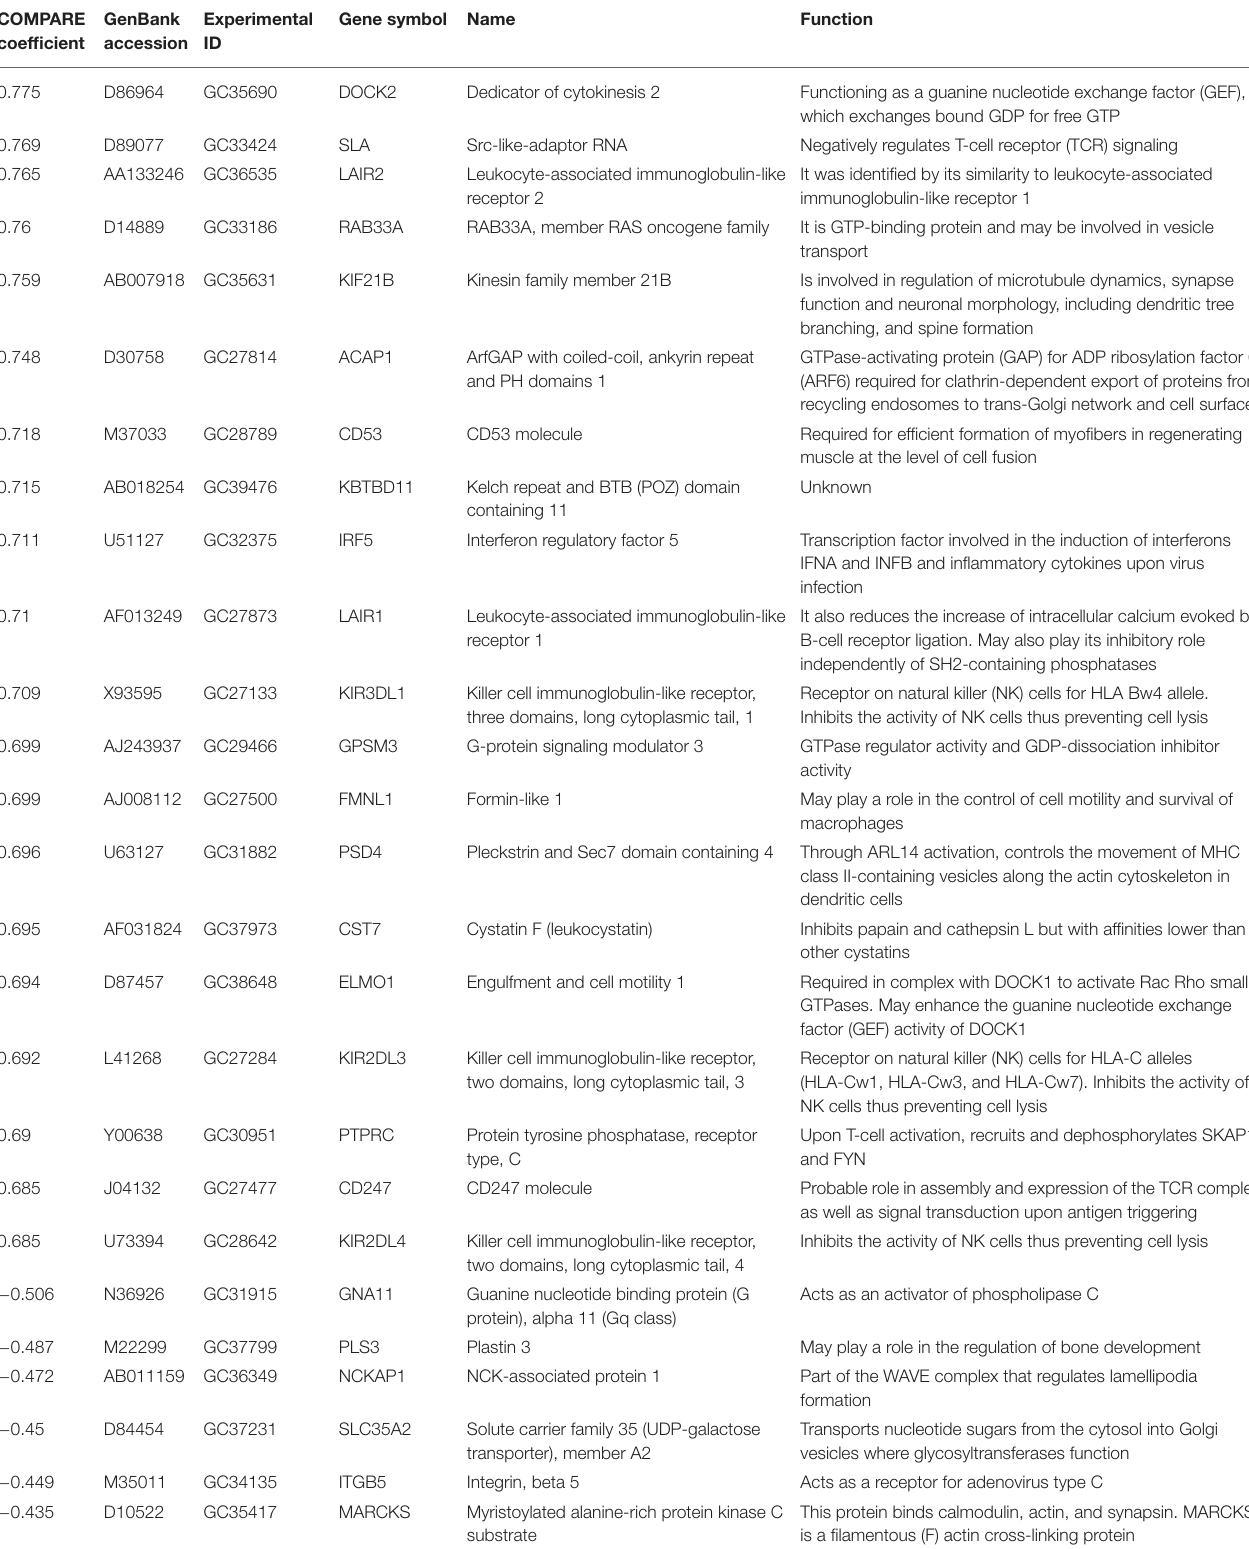
TABLE 3 | Correlation of constitutive mRNA expression of genes identified by COMPARE analysis with log 10 IC 50 values for sanguinarine of the NCI tumor cell lines. COMPARE GenBank Experimental coefficient accession